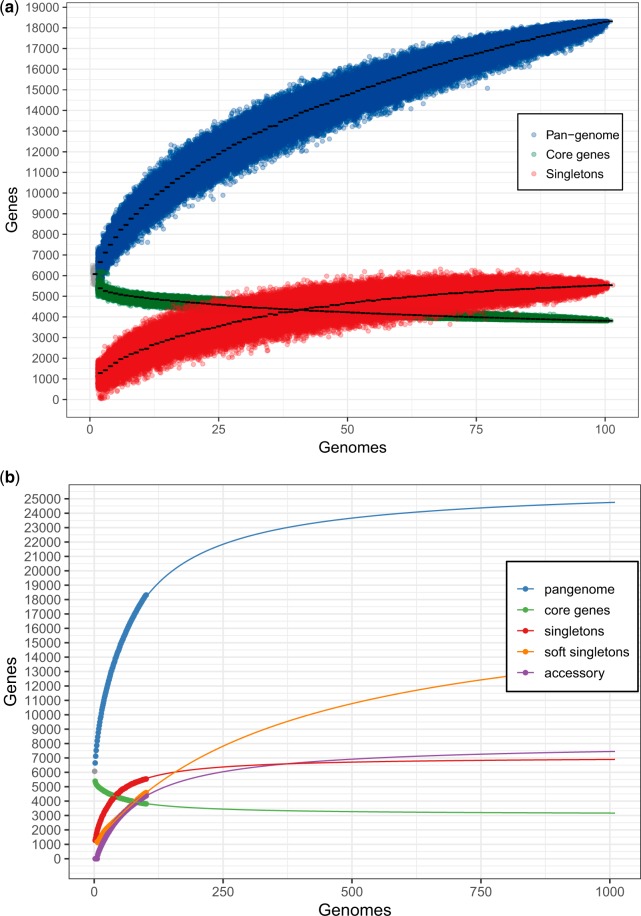
—Influence of the number of sequenced genomes on the P. aeruginosa pan- and core-genome size. (A) The number of genes belonging to the pan-genome (blue dots), core genome (green dots), and singletons (red dots) is plotted as a function of genomes sequentially added in all possible combinations (limited to 1,000). (B) Saturation model of for the pan (blue), core (green), singleton (red), soft singleton (genes present in only 2–5% of the isolates, orange), and accessory (purple) genomes. On 101 genomes, the model predicts a pan-genome saturation of 95% with 940 genomes that correspond to a pan-genome size of 25,946 genes.